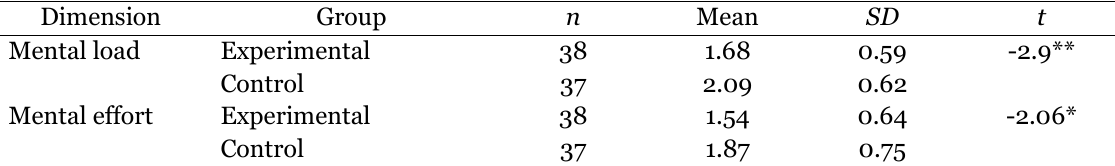
Independent Sample t Test Results for Mental Load and Mental Effort Dimension Group Mental